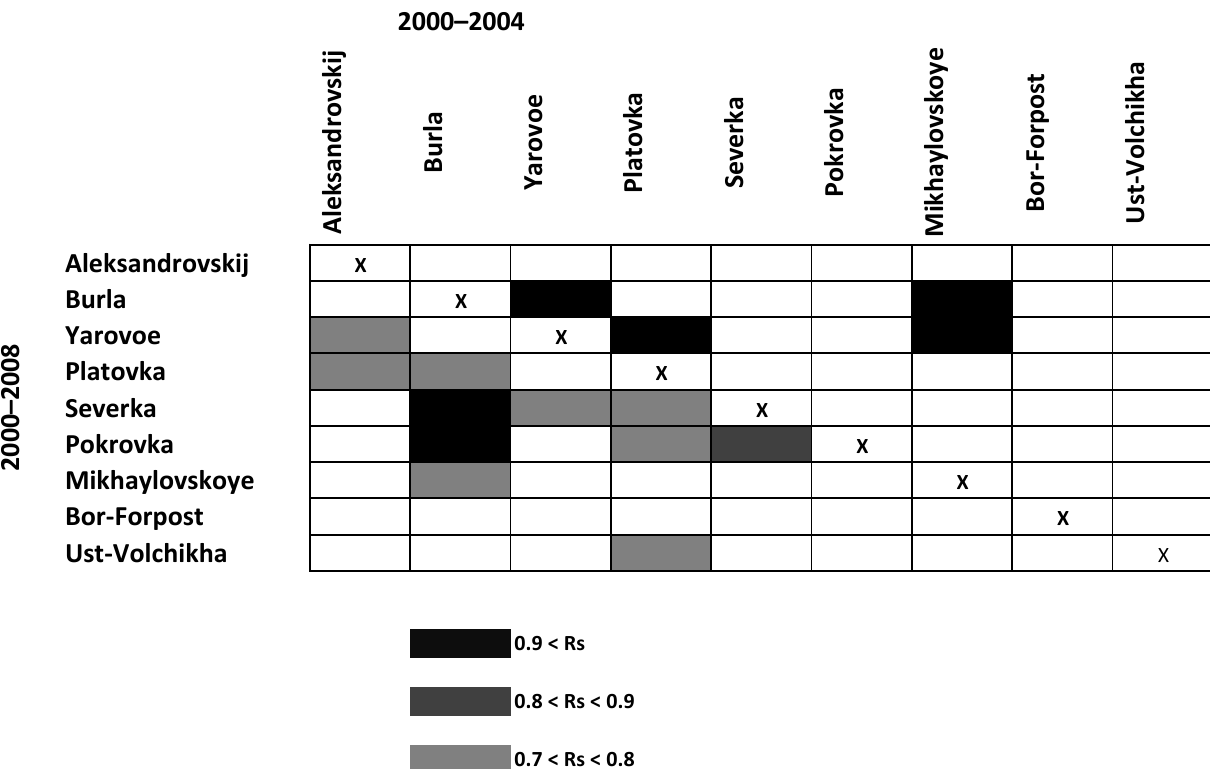
Figure 7. Associations between the long-term dynamics of the Italian locust populations in the Kulunda steppe for 2000–2004 and 2000–2008 (levels of the Spearman rank order correlation—Rs, p <